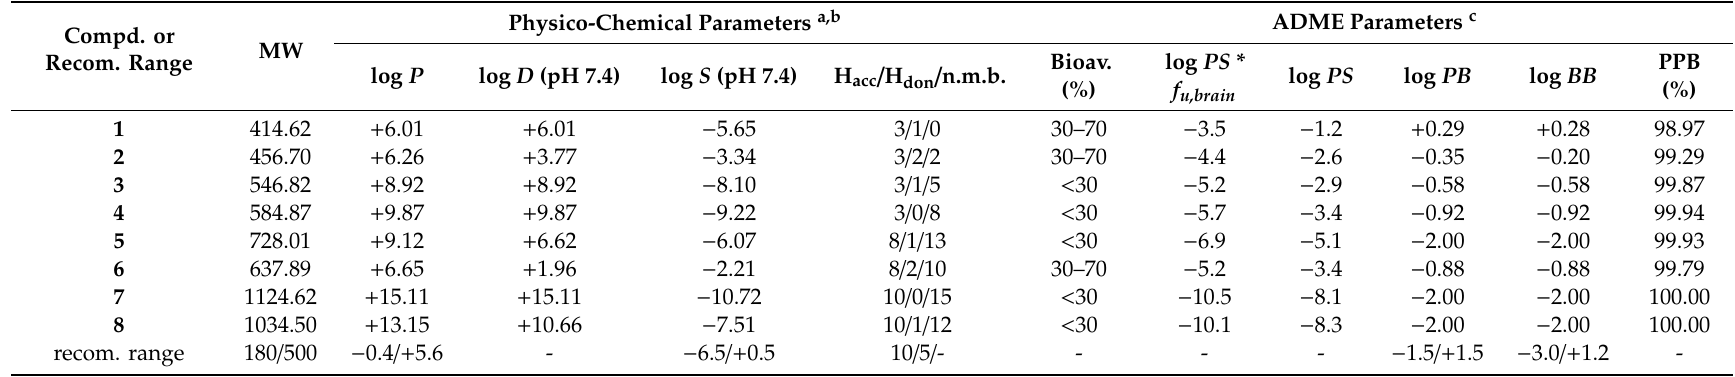
1034.50 recom. range 180 / 500 − 0.4 /+ 5.6 - − 6.5 /+